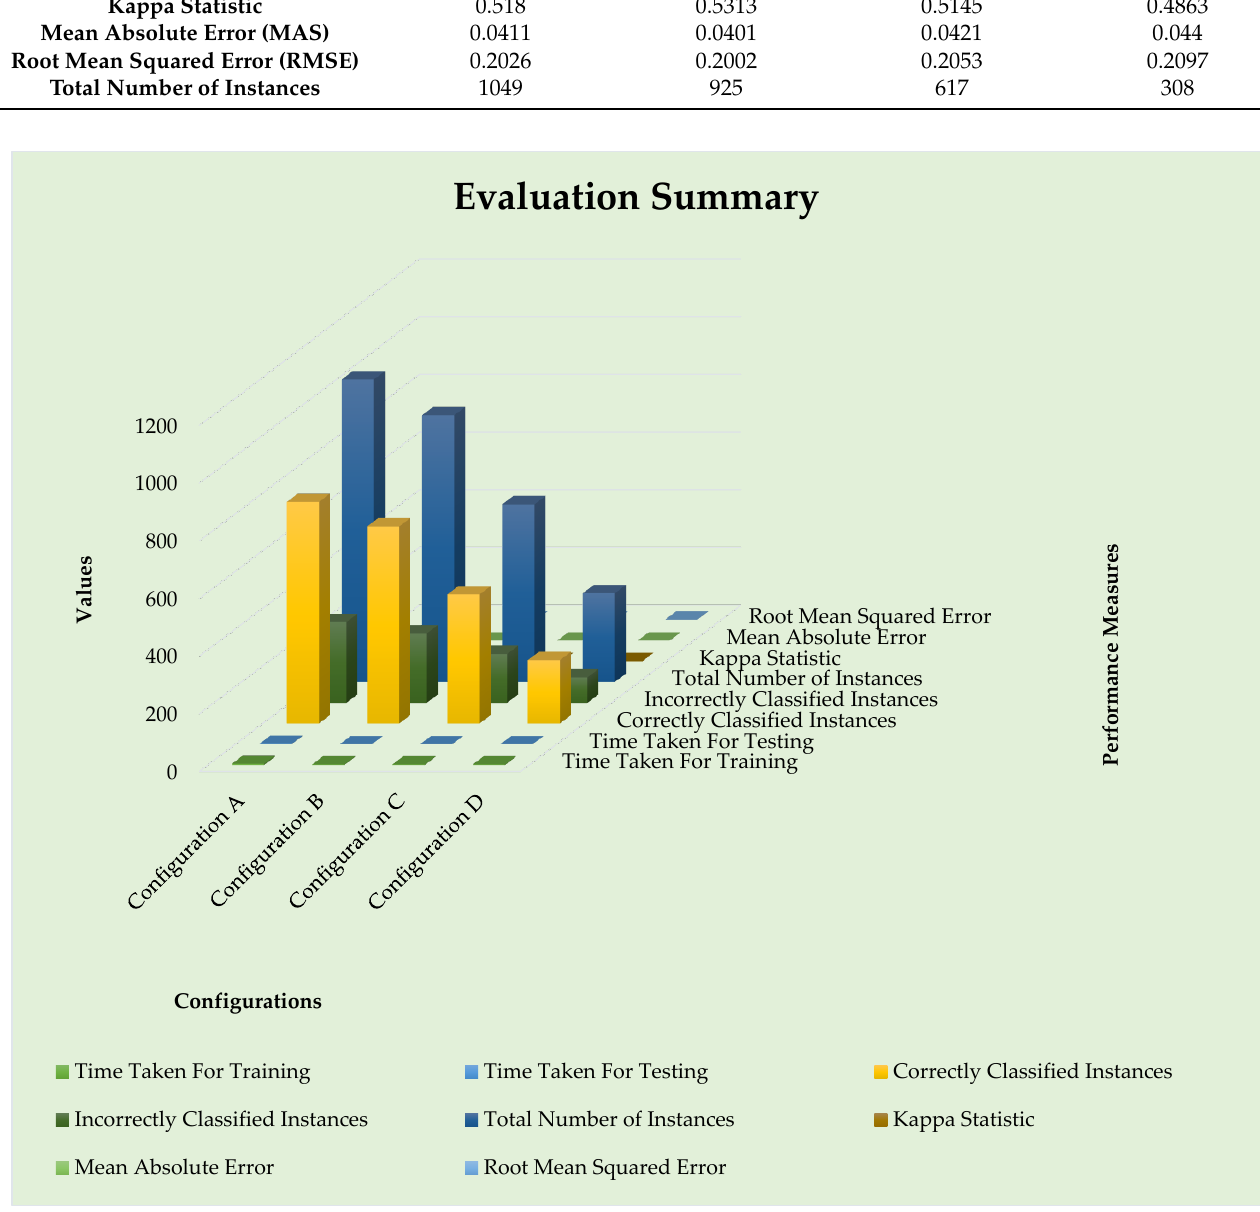
Figure 5. Graphical representation of evaluation on split test (single feature selection technique). Table 3. Evaluation of test split (single feature selection technique).